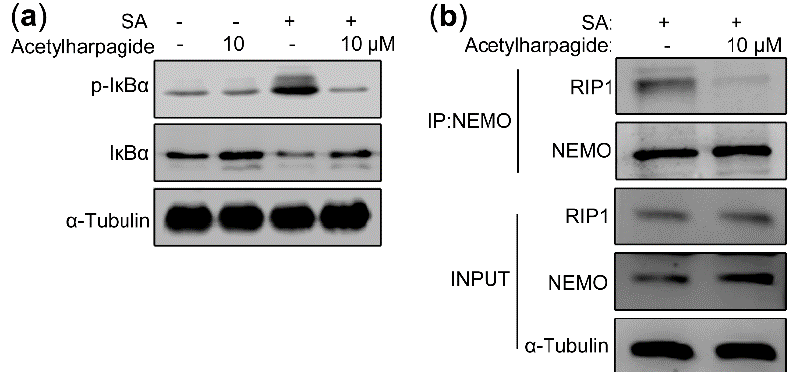
Figure 7. Acetylharpagide inhibited the interaction between polyubiquitinated RIP1 and NEMO upon S. aureus (SA) stimulation. ( a ) Raw264.7 cells were pretreated with acetylharpagide or DMSO for 2 h, then stimulated with S. aureus (multiplicity of infection (MOI), 10:1) for 2 h. The expressions of I κ B α and phosphorylated I κ B α in cellular lysates were analyzed by western blot; ( b ) Raw264.7 cells were stimulated as in A. Cellular lysates were subjected to immunoprecipitation with an anti-NEMO antibody followed by immunoblotting with anti-NEMO and anti-RIP1 antibodies.